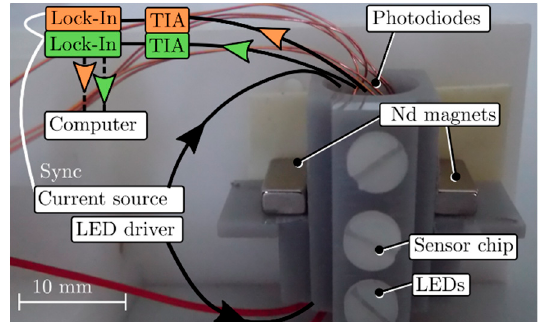
Figure 2. Measurement setup and schematic. A custom made 3D-printed mounting device provides a centered placement of the sensor chip between the neodymium (Nd) magnets. Depending on the orientation of the magnets either a gradient or a homogeneous B-field is realised. A pure gradient field is accomplished by anti-symmetric placement of the magnets, whereas a gradient field with offset occurs when a single magnet is used. Symmetric placement of the magnets generates a homogeneous field. Nylon screws ensures a distortion free magnetic field and fasten LEDs, sensor and